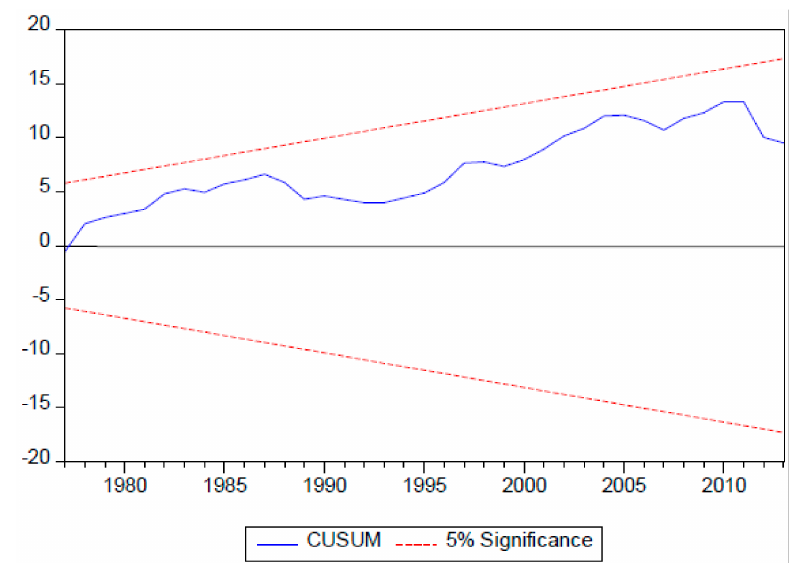
Figure 11. Plot of cumulative sum of recursive residuals for Vietnam.